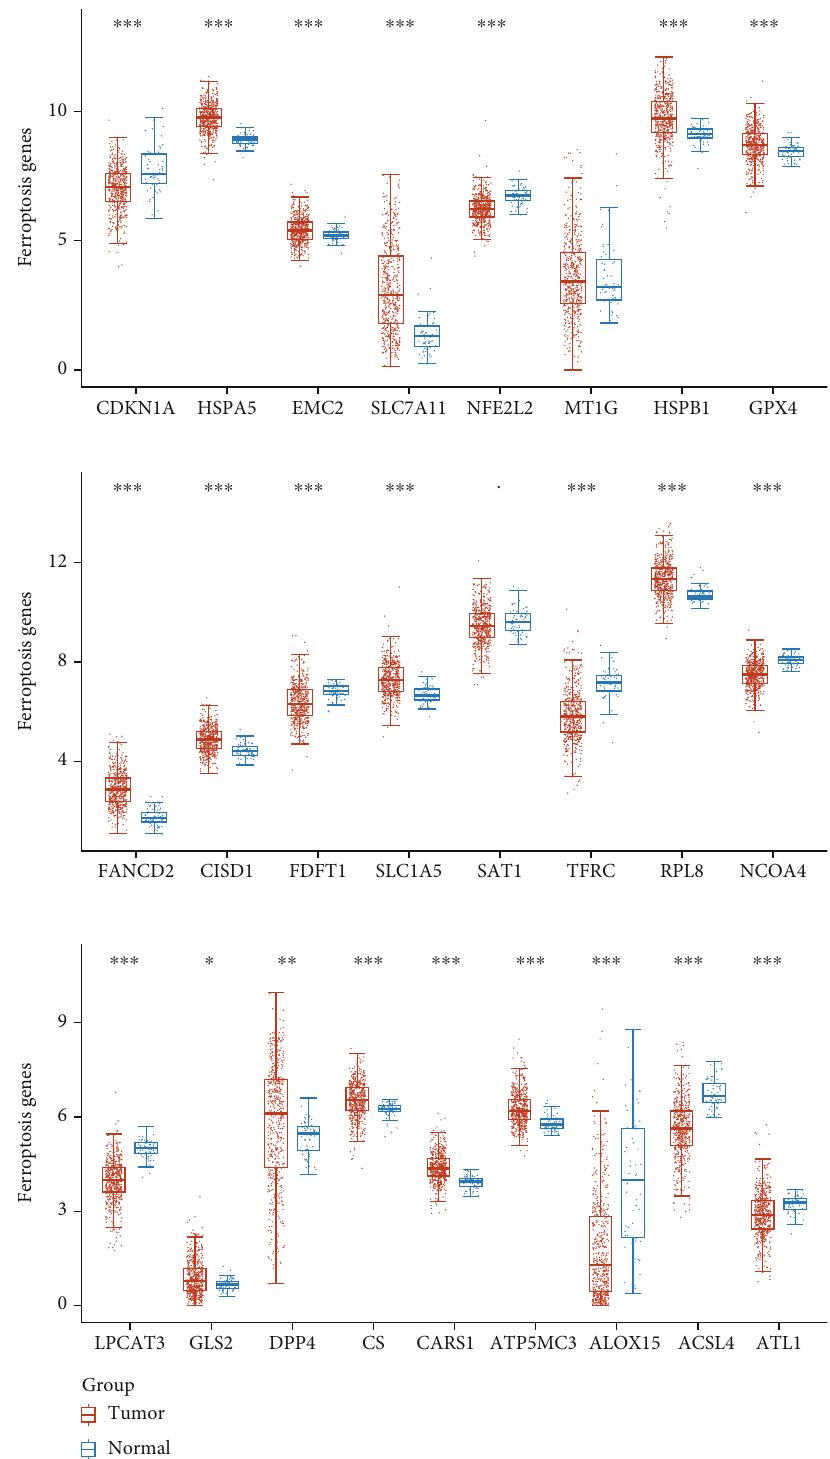
Figure 1: The expressing pattern of ferroptosis-associated genes in LUAD using TCGA datasets. ∗∗∗ p < 0 : 001, ∗∗ p < 0 : 01, and ∗ p < 0 : 05